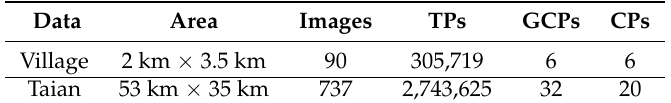
Table 3. The parameters of the real datasets.